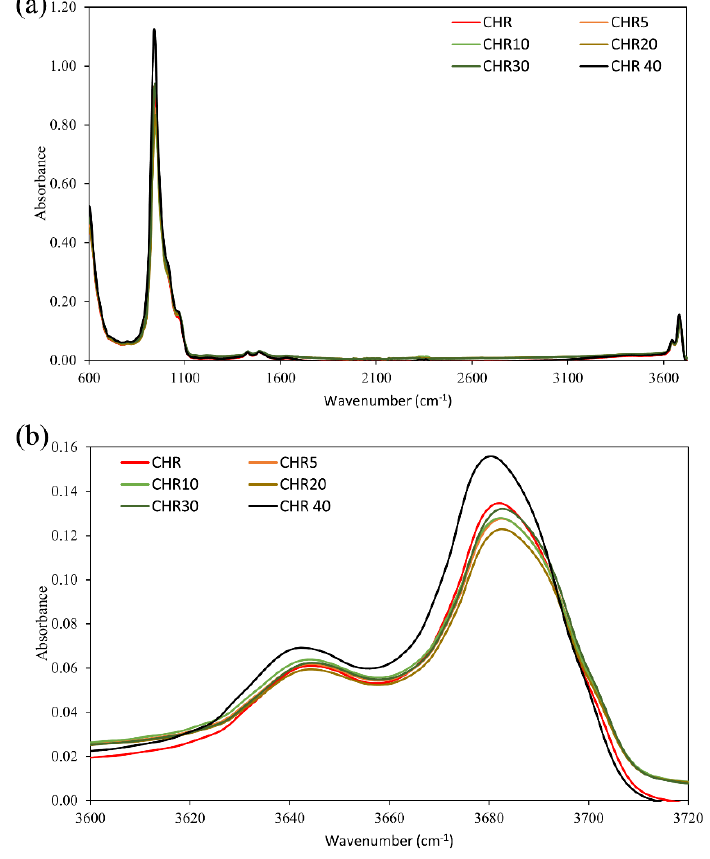
Figure 5. ( a ) FTIR spectra (600–4000 cm –1 ) of raw Russian chrysotile (CHR), chrysotile after 5 min of milling (CHR5), chrysotile after 10 min of milling (CHR10), chrysotile after 20 min milling (CHR20), chrysotile after 30 min of milling (CHR30) and chrysotile after 40 min of milling (CHR40). ( b ) The OH-stretching region.